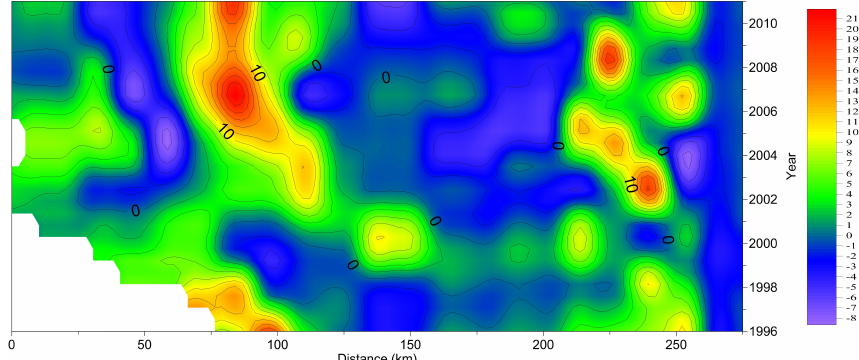
Fig. 6. Section “N” along 76 ◦ 30 0 N. Hovmoeller diagram of the baroclinic velocity at 200dbar. Positive values indicate the northward flow.